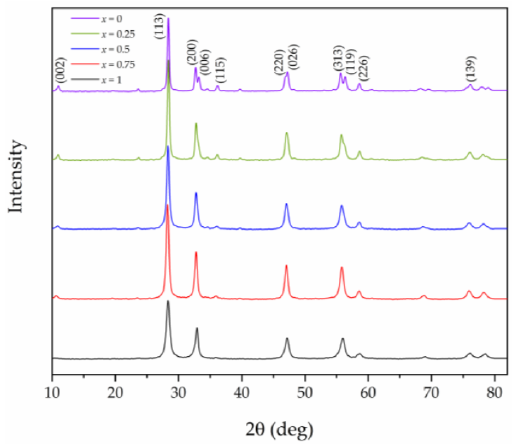
Figure 1. XRD patterns of as-prepared Bi 2 W x Mo 1 − x O 6 perovskites.